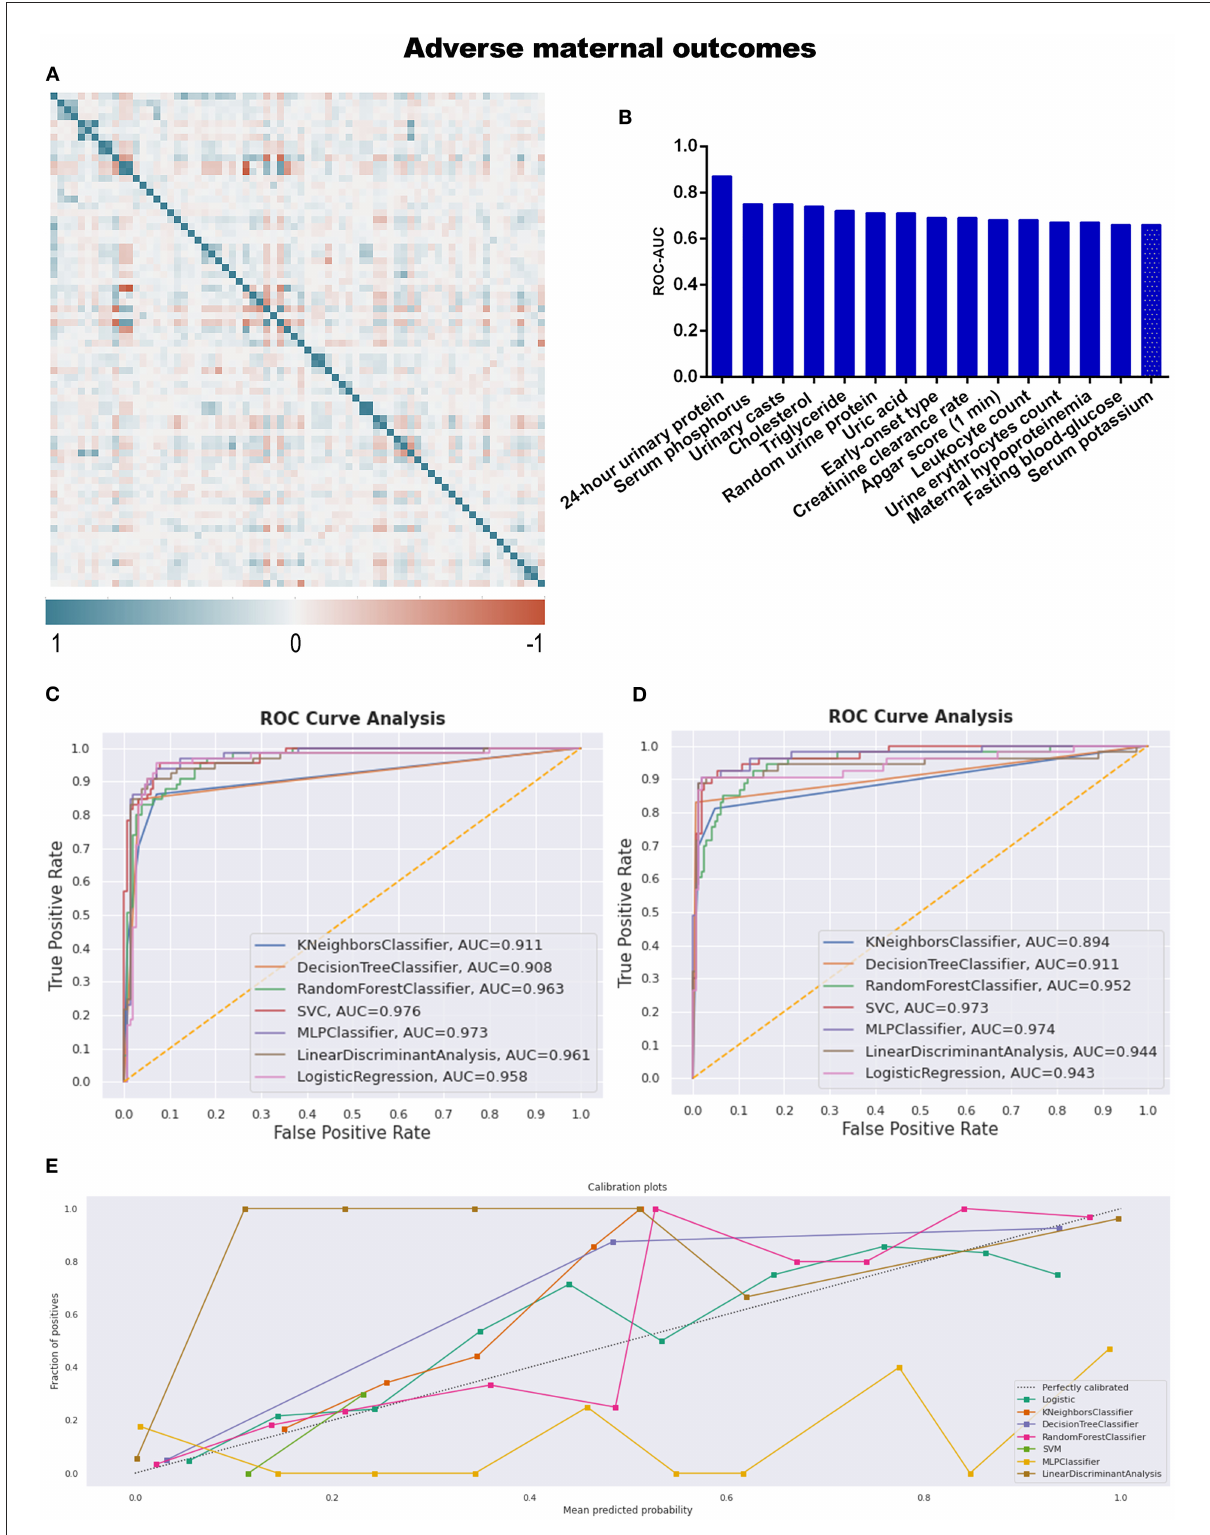
FIGURE3 (A) The generated heat map according to correlation analysis to screen independent variables for adverse events; (B) feature selection of Top 15 adverse outcomes predictive variables according to the value of AUC calculated by DT algorithm; (C) the ROC-AUC values of machine learning and logistic regression predictive models developed from the imputed dataset; (D) the AUC values of models developed from the dataset without imputation; (E) the calibration curve generated from the models developed from imputed